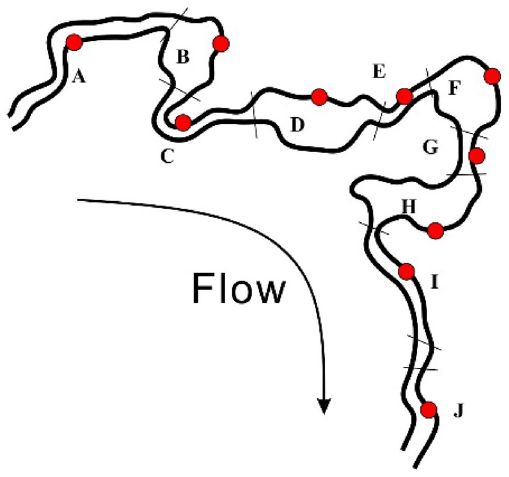
Figure 1. Sample locations at the surface-flow constructed